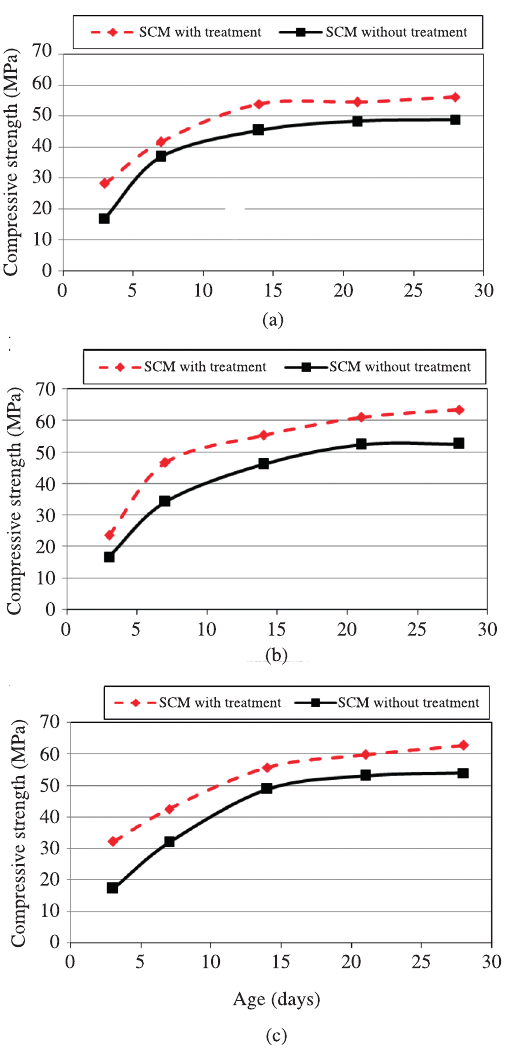
Figure 7. Evolution of the compressive strength of the SCMs mortars respectively with and without heat treatment as a function age; (a) SCM(R) (b) SCM(CS) (c) SCM(GWB).